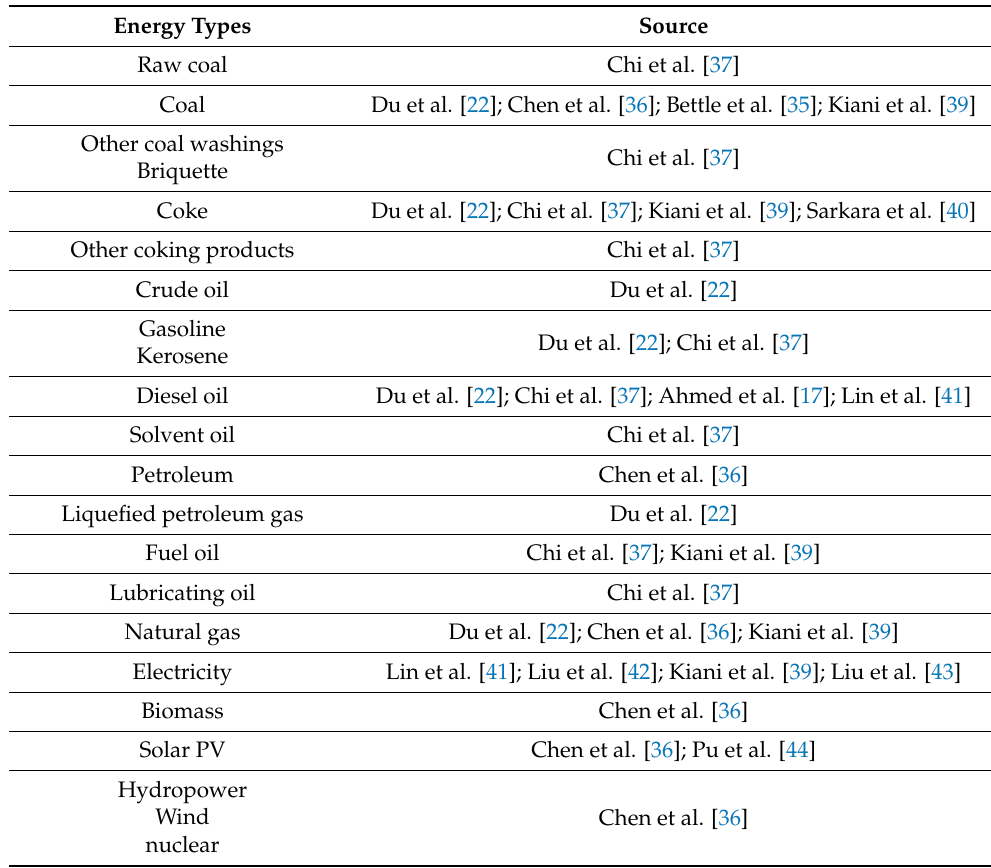
Table 1. Energy CEFs based on